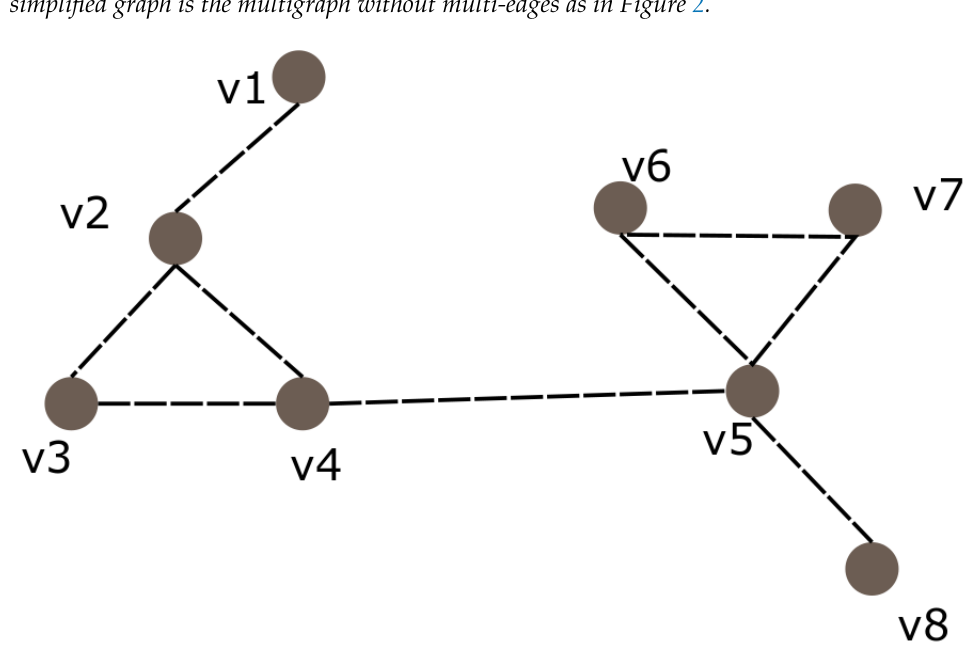
Figure 2. A Simplified graph Σ ( G ) .